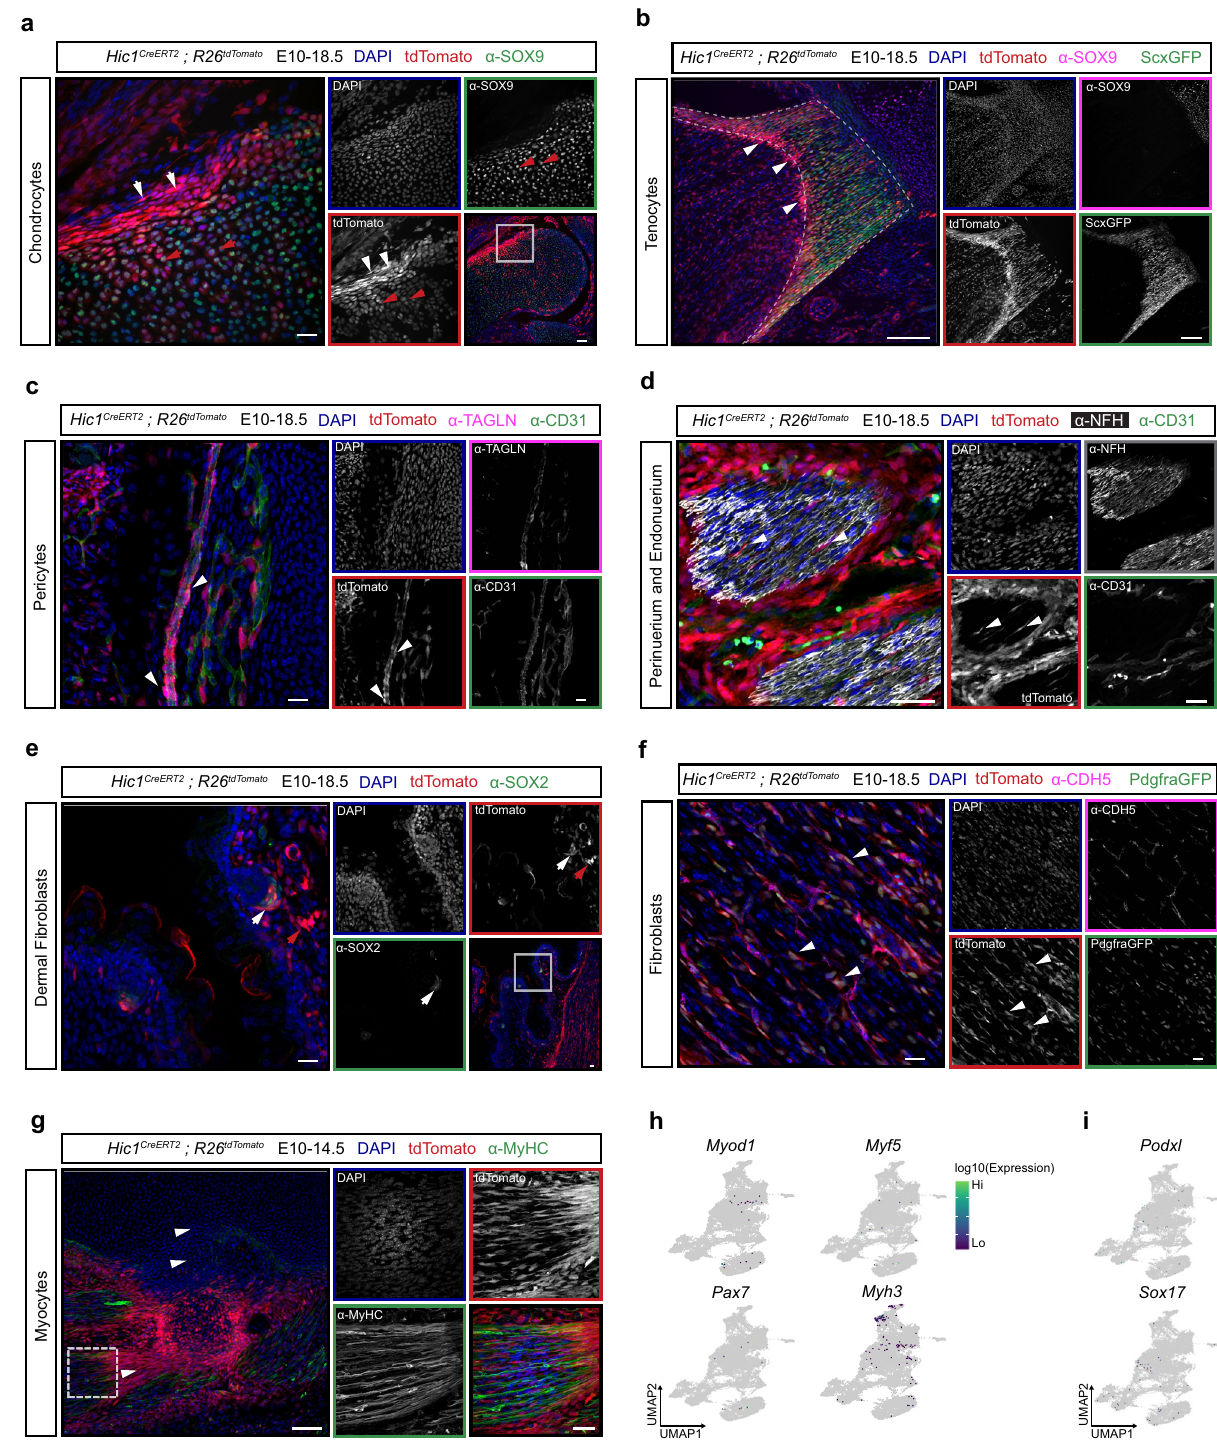
Fig. 4 | Lineage tracing analyses con fi rm computationally inferred lineage potential. a – f Representative immuno fl uorescence images of E18.5 Hic1 CreERT2 ; R26 tdTomato forelimbs of tdTomato + MP-derived cells demonstrating contribution to the following lineages: chondrocytes and perichondrium. White arrowheads indi- cate perichondrium, red arrowheads highlight tdTomato + chondrocytes; b tenocytes; c pericytes; d perineurium and endoneurium cells. White arrowheads indicate endoneurial cells; PDFPs and RDFPs highlighted by white and red arrow- headsrespectively( e );and fi broblasts( f ).Whiteboxesin a , e , g highlightregionsof